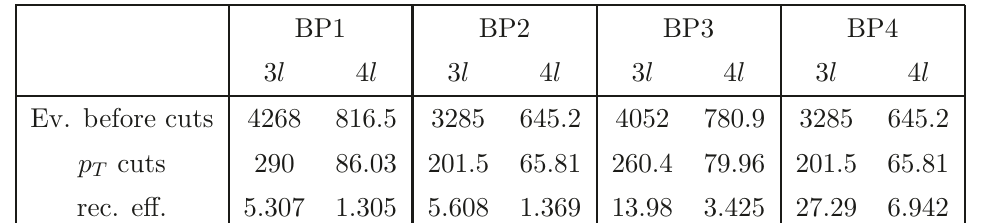
Table 9. Displaced leptons originated from heavy neutrinos produced by the SM-like Higgs. For each BP the initial number of events generated is the cross section σ ( pp by a luminosity of 100 fb − 1 . A 3 l -trigger has been employed. The p T cuts are applied in the following way: p T > 20 GeV for the most energetic lepton and p T > 15 GeV for the other two. A p T > 5 GeV is required on the forth lepton, when present. Only the events surviving the final selection procedure and the cuts on the p T are